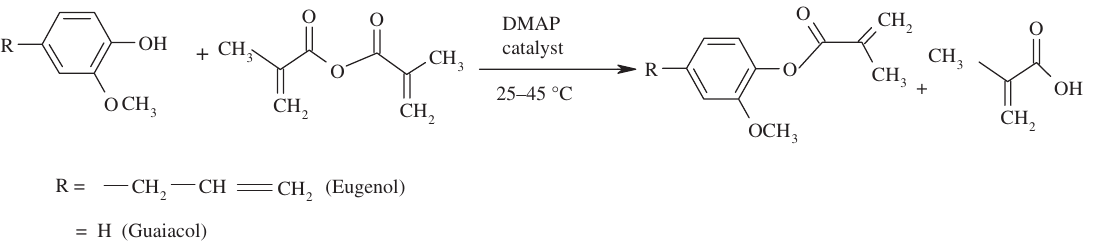
Figure 2: Reaction scheme for the synthesis of ME and